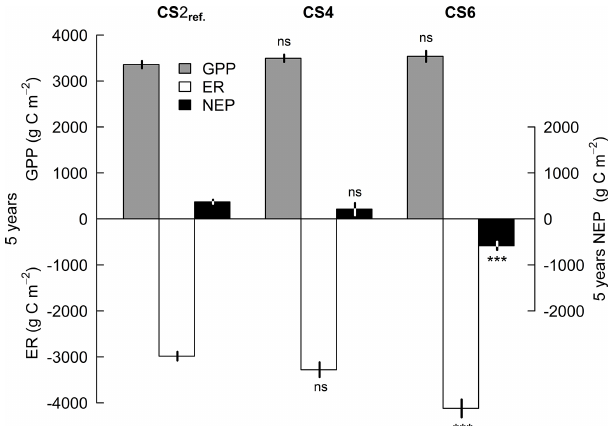
Figure 4. C flux balance of 5-year totals of gross primary produc- tivity (GPP), ecosystem respiration (ER) and net ecosystem produc- tivity (NEP) at three climate scenario sites. Displayed are means ± 1SE of the control treatment that received neither irrigation nor additional N. Significance tests are against CS2 reference within each C flux category; moreover, all three means to NEP were signifi- cantly different from zero ( P < 0 . 05). ∗∗∗ P < 0 . 001. ns P > 0 .